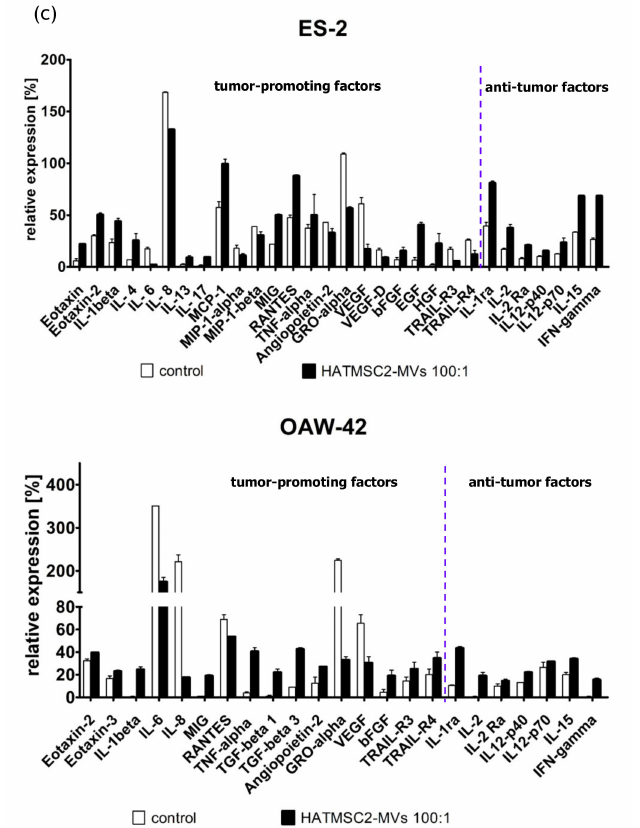
Figure 8. E ff ect of HATMSC2-MVs on the secretion profiles of ovarian cancer cell lines. ( a ) Scans of representative antibody arrays for ES-2 and OAW-42 supernatants. Untreated cells served as a control. The signal intensity for each antibody spot is proportional to the relative concentration of the antigen in the sample. ( b ) Heat map of cytokine levels for the ES-2 and OAW-42 supernatants; magenta and yellow indicate higher and lower expression limits, respectively. Outstanding values (above 100% of positive control) are depicted in red. Data are normalized to the internal positive control spots, which are consistent between the arrays and represent 100%. The data represent the mean from a duplicate assessment. ( c ) Column graph representing selected proteins (equal to or above 10% of the positive control). The data are presented as mean ± SEM values from a duplicate